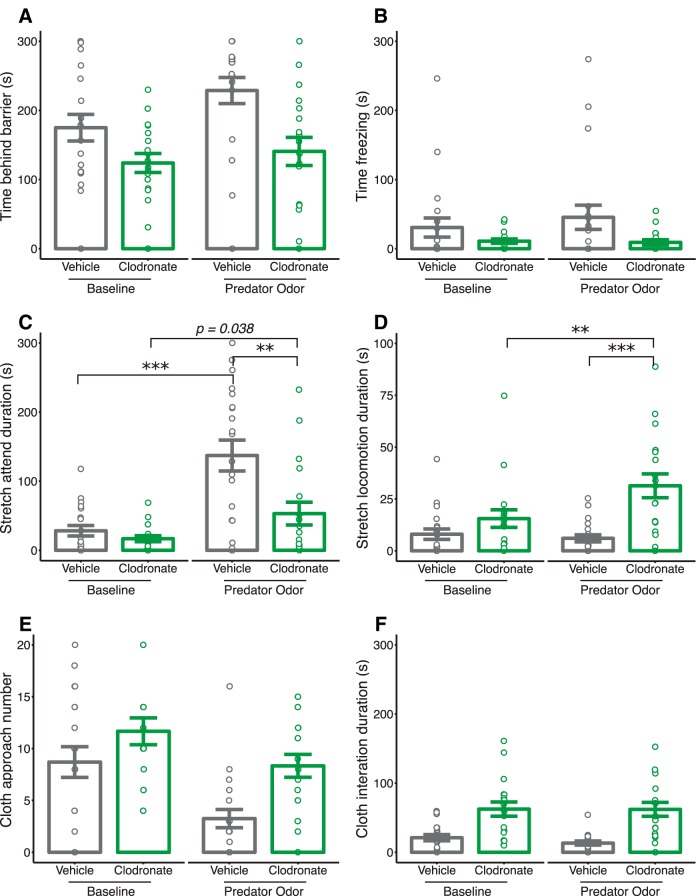
Microglia-depleted animals exhibit decreased fear and avoidance but display risk-assessing behaviors. Quantification of data from the predator odor exposure test (PN33) for time (in seconds) spent in various behaviors including time behind the barrier (a), freezing behavior (b), stretch-attend behavior (c), stretch-locomotion behavior (d), number of stimulus cloth approaches (e), and stimulus cloth interaction duration (f). Bars indicate group means ± SEM for VEH-treated (black) and LC-treated (green) rats of both sexes. Open circles represent data from individual rats. *p < 0.05, **p < 0.01, ***p < 0.001. n = 18–20 per treatment.